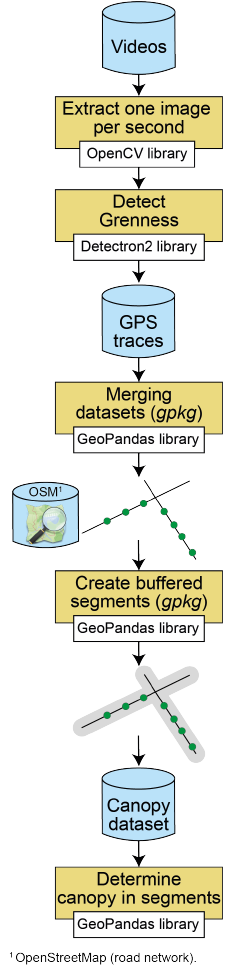
Figure 2. Data processing in Python.